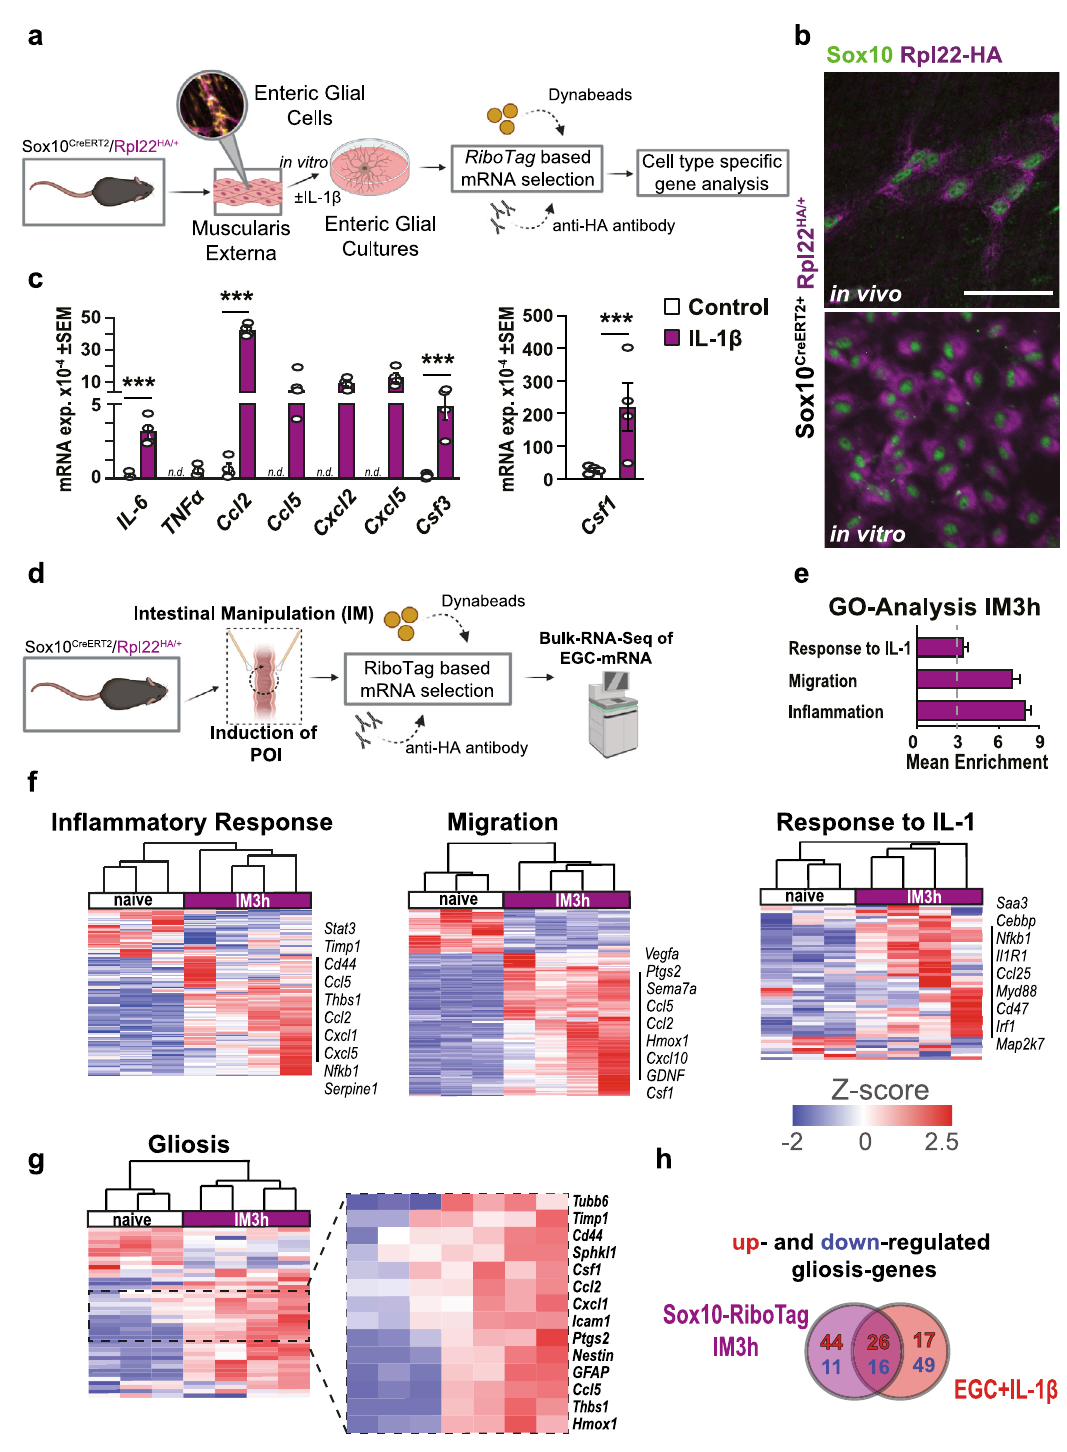
Fig. 2 IL-1-induced enteric gliosis resembles the EGC reactivity pro fi le after surgical trauma. a Schematic overview of the RiboTag method applied in primary EGCs treated with IL-1 β (10 ng/ml) or vehicle (control) for 3 h and processed for qPCR. n = 4 per group. b Representative immuno fl uorescence microscopy for EGCs (SOX10 + , green) and the RiboTag (HA + , violet) in vivo (small intestine ME ) and in vitro (EGC cultures) from Sox10 CreERT2 + -Rpl22 HA/ + mice. Scale bar 50 µ m. c qPCR analysis for gliosis-associated genes in primary EGCs treated with IL-1 β . Bars showing mean gene expression compared to 18S. n = 4. d Schematic overview of the RiboTag method applied in the POI animal model. Sox10 CreERT2 + -Rpl22 HA/ + mice underwent intestinal manipulation to induce POI, and EGC-speci fi c mRNA was immunoprecipitated and used for bulk-RNA-Seq. n = 3 – 4 per group. e GO analysis of enriched genes at IM3h. f Heat maps of genes involved in “ in fl ammatory response ” , “ response to IL-1 ” , and “ migration ” . g Heat map of genes involved in “ gliosis ” highlighting the induced gene panel. h Venn-diagram of differentially expressed gliosis genes in IL-1 β -treated EGCs and Sox10 CreERT2 + -Rpl22 HA/ + mice at IM3h. Statistics were done with Student ’ s t -test. ***<0.001, * were compared to untreated EGC